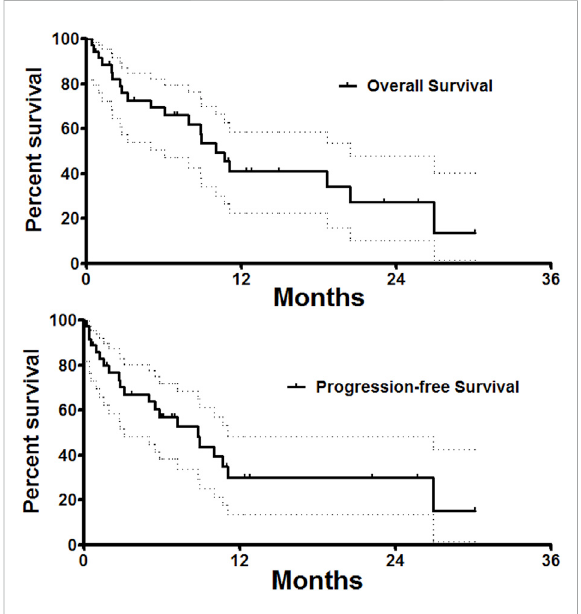
FIGURE 5 Follow up. Median overall survival and progression-free survival was 10.0 and 8.8 months. The 3-, 6 and 12 months overall survival rates were 88.5%, 72.7%, and 40.9%,